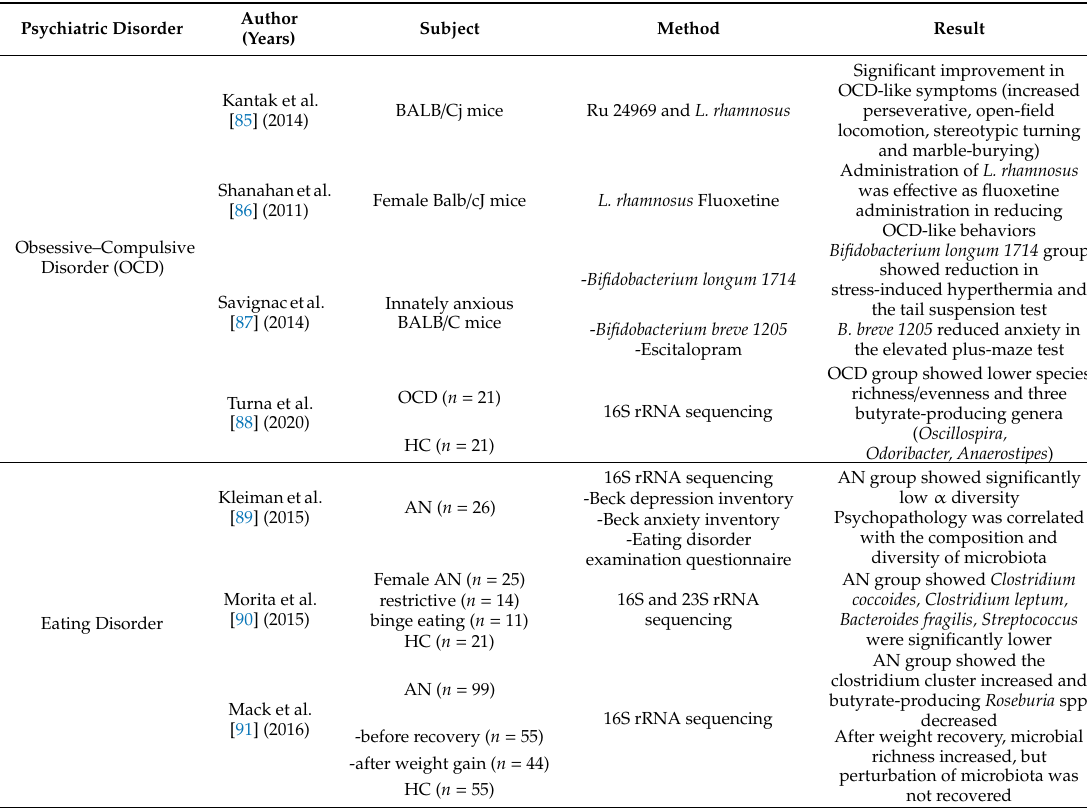
Table 5. Characteristics of prior studies investigating the relationship between microbiome and Obsessive Compulsive Disorder, Eating